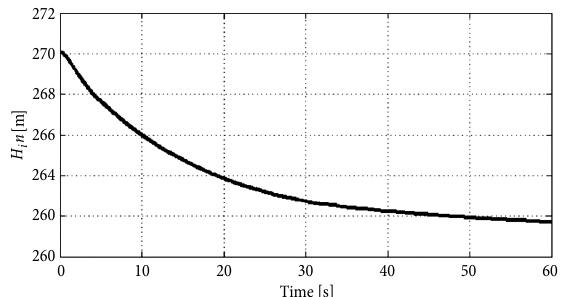
Fig. 4. Water column height variation